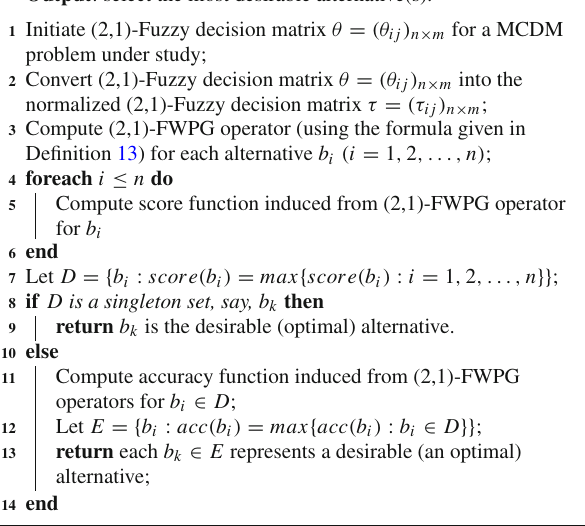
Algorithm 4: The algorithm of selection the optimal alternative(s) with respect to (2,1)-FWPG